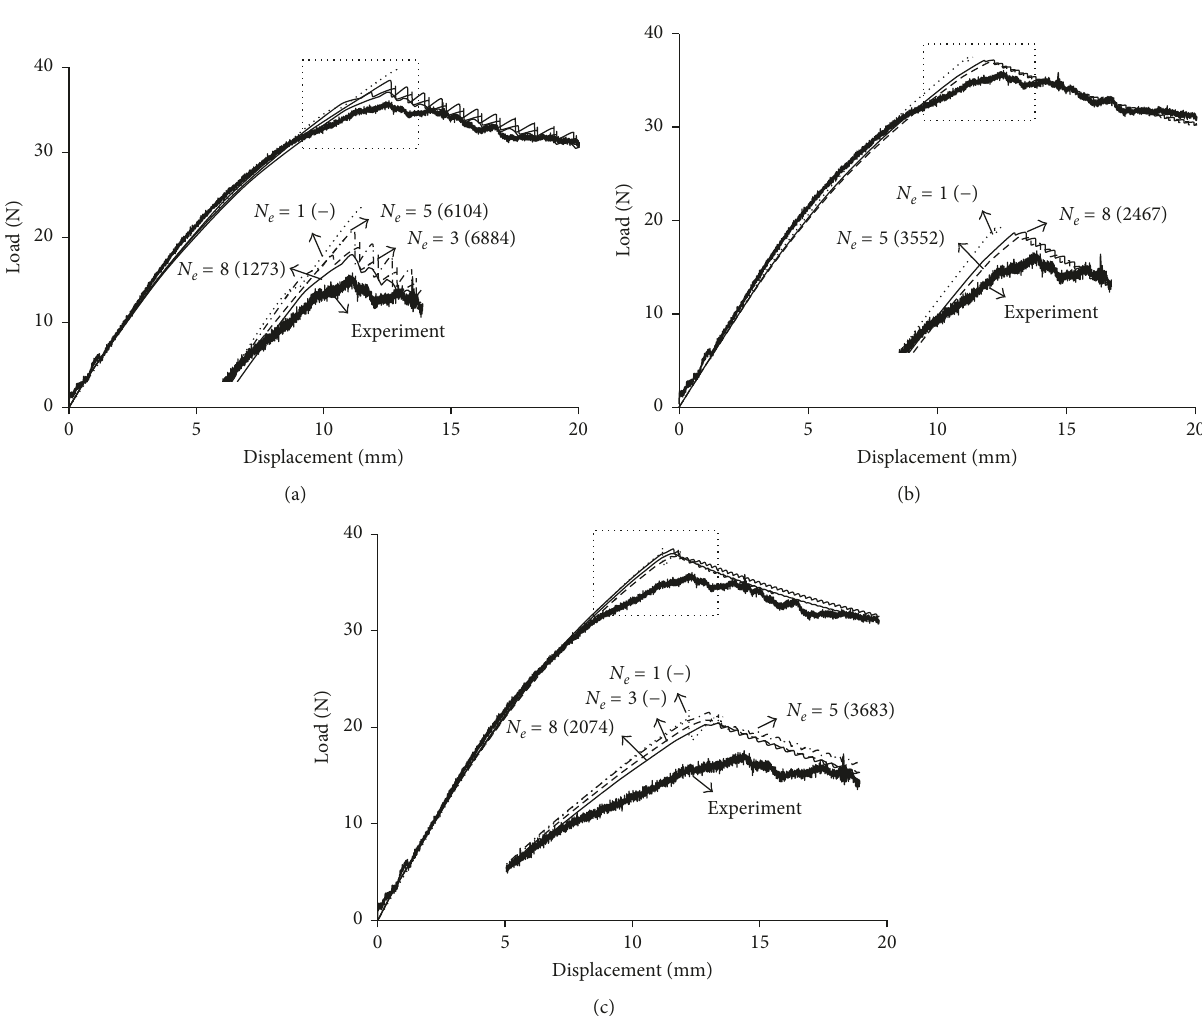
l e (cid:31) 1mm, (b) e (cid:31) 0.5 mm, and